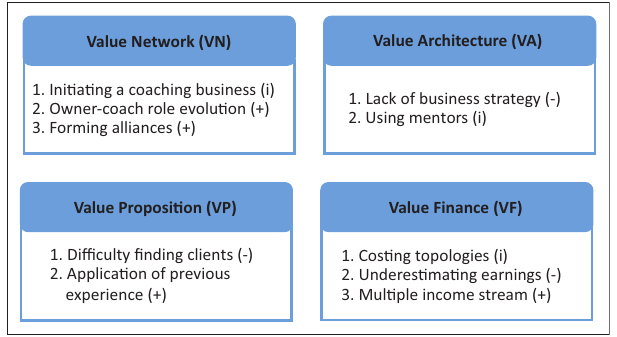
FIGURE 1: Themes relating to the four business model